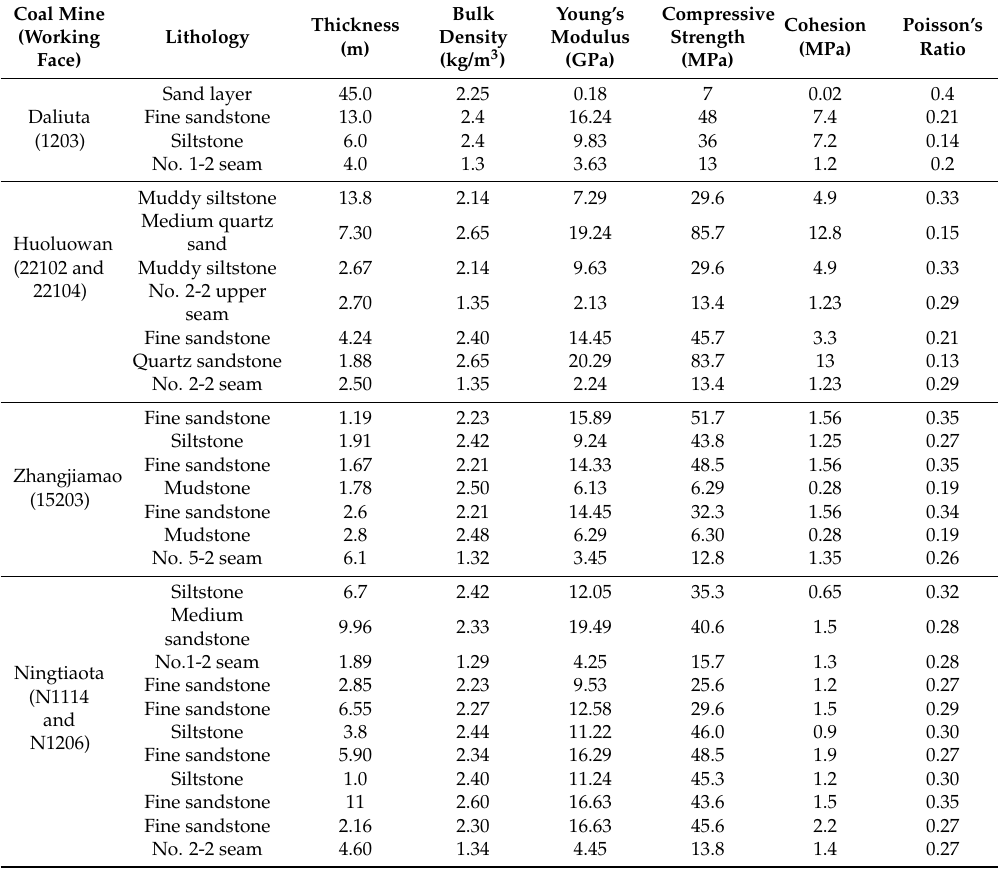
Table 1. The parameters of coal and its roof and floor of four